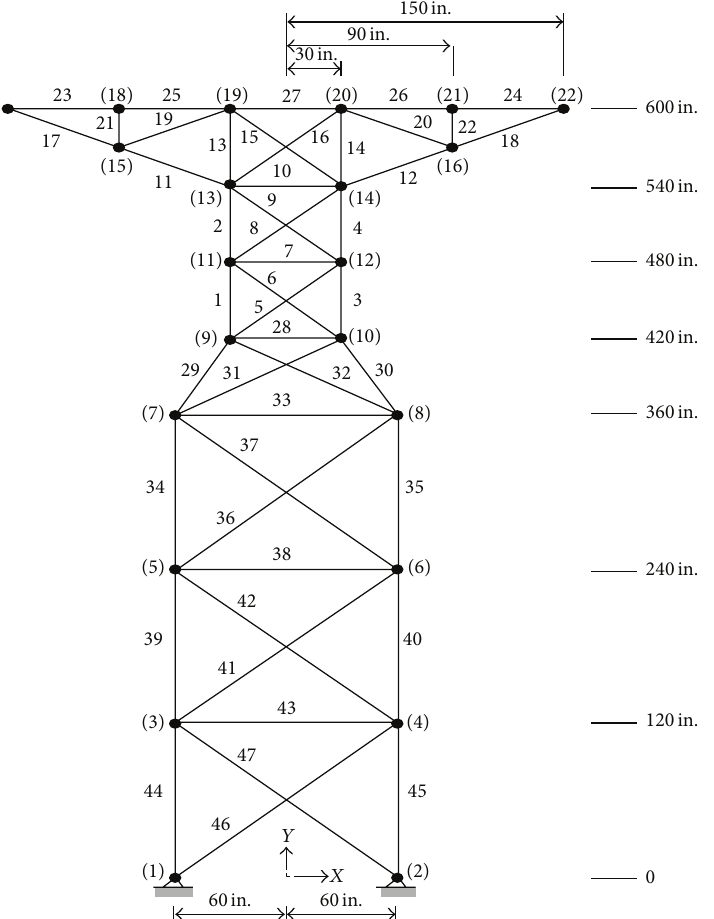
Figure 8: Forty-seven-bar planar power line